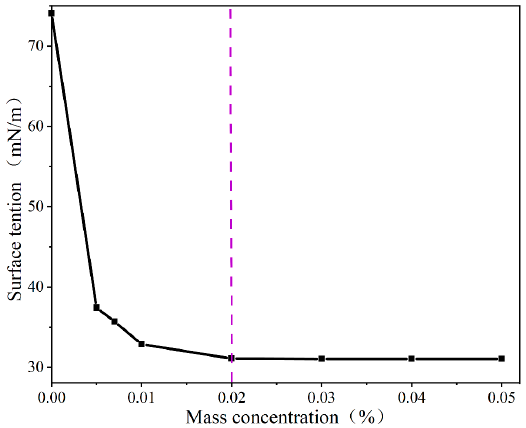
Figure 7. The surface tension of the AEO-9 solution at different concentrations.